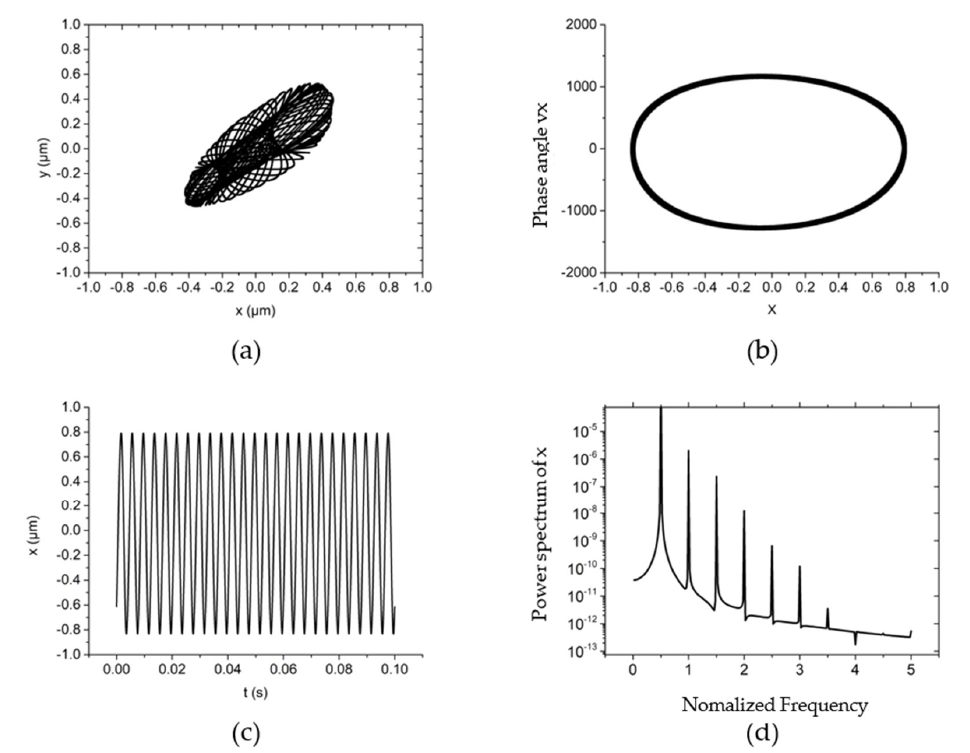
Figure 9. The non − linear dynamic behavior of the rotor at w = 50,000 r/min, Fy = 30 N, m u = 0.1 g, m = 90 g. ( a ) Rotor center trajectory, ( b ) Phase angle in x direction, ( c ) X displacement time ‐ domain curve, ( d ) Power spectral density in the x direction.